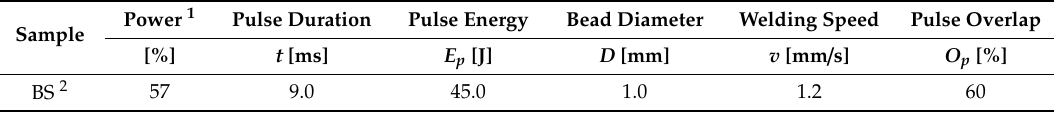
Table 3. Selected set of process parameters to weld the Gen3 980T steel sheet on both sides.